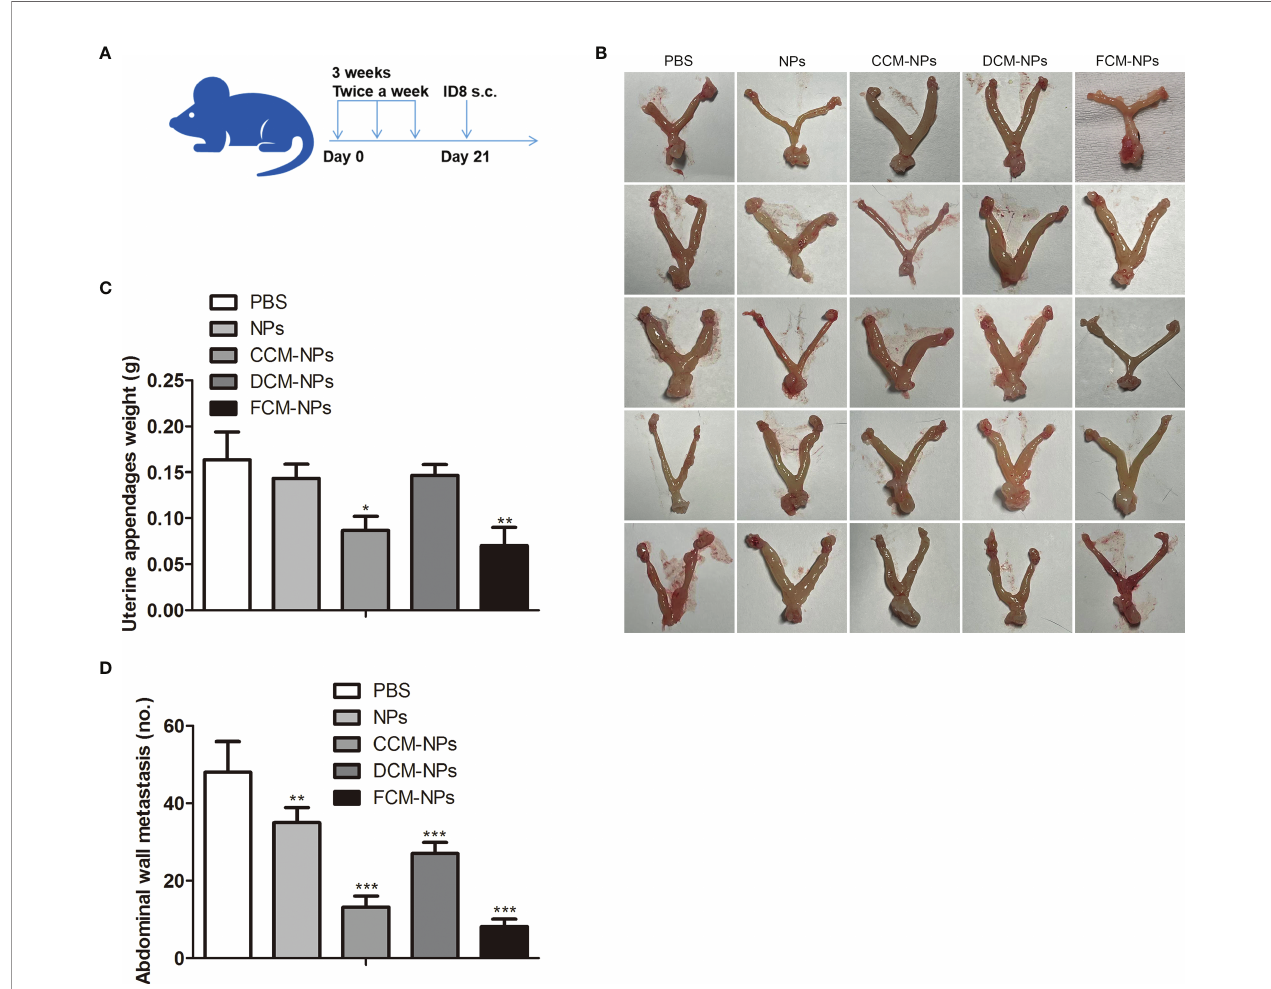
FIGURE 7 | Therapeutic effect of FCM-NPs on abdominal metastatic ovarian cancer model. (A) Schematic diagram of modeling and treatment of abdominal metastatic tumor in mice. (B) Images of adnexa uteri of mice treated with PBS, NPs, CCM-NPs, DCM-NPs and FCM-NPs. (C) Weight of adnexa uteri in mice of each group. * P < 0.05, ** P < 0.01 vs PBS group. (D) The quantitative results of the metastatic tumor nodules on the abdominal wall. ** P < 0.01, *** P < 0.001 vs PBS